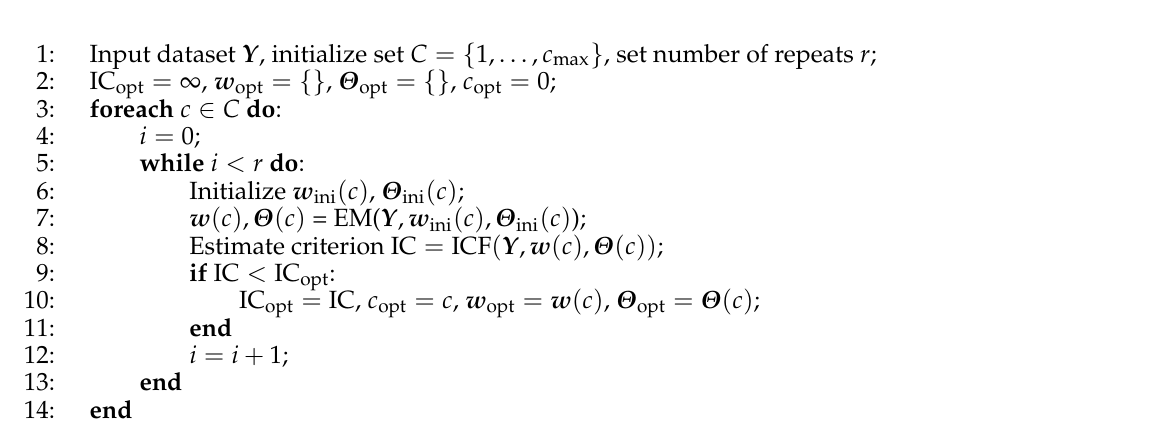
Algorithm 3: Model-selection procedure with multiple